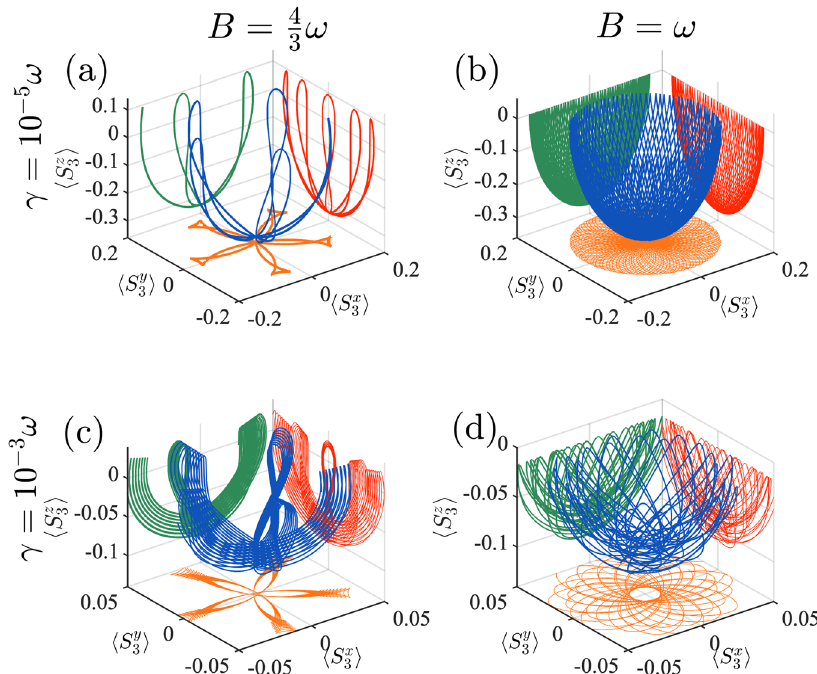
i (cid:2) h S y i (cid:2) h S z i space, ( a , b ) for stable discrete time crystal (DTC) and discrete 3 3 3